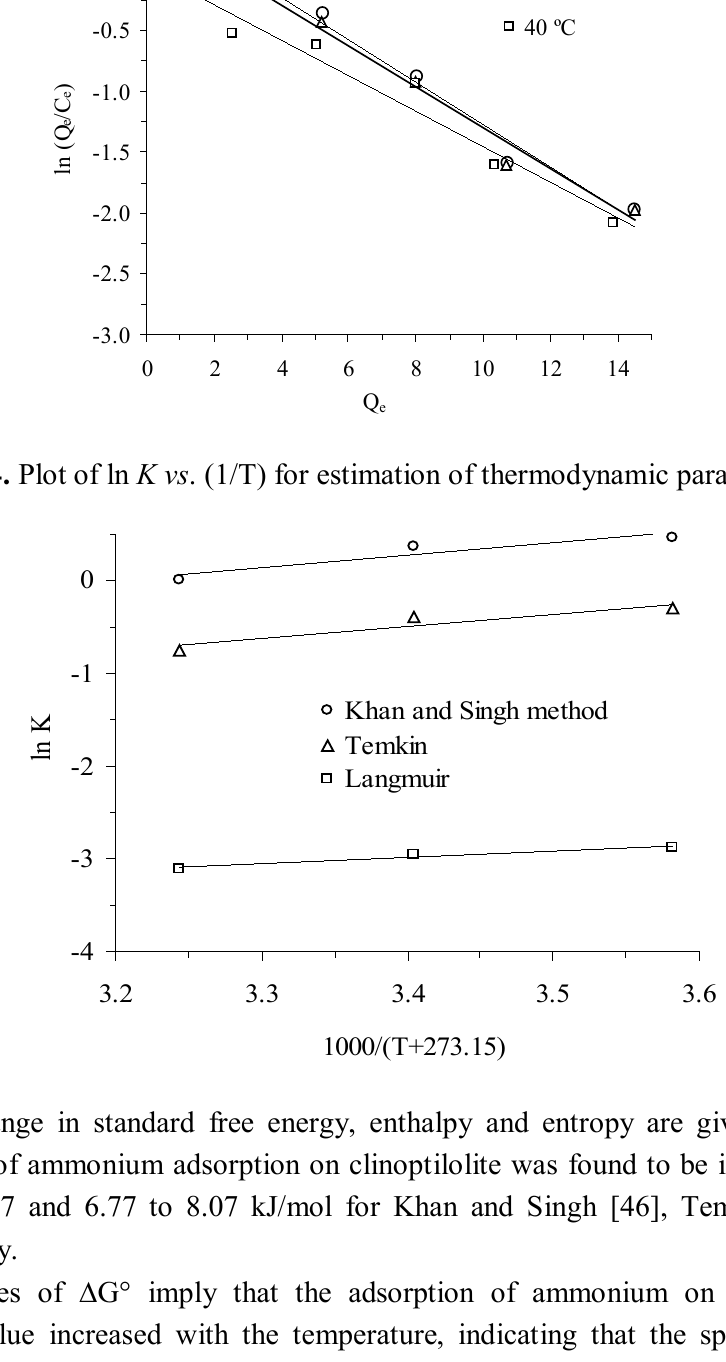
/ C ) vs . Q at various temperatures for the determination of e e e